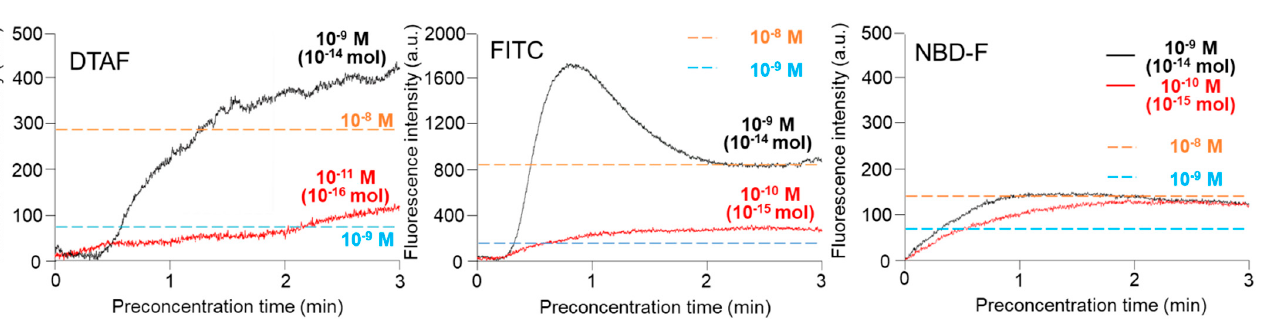
Figure 2. Time-course of fluorescence intensity changes of 5-(4,6-dichlorotriazinyl)aminofluorescein (DTAF), fluorescein isothiocyanate (FITC), and 4-fluoro-7-nitrobenzofurazan (NBD-F)-labeled monophosphorylated β -casein. The concentra- tions of DTAF, FITC, and NBD-F-labeled monophosphorylated β -casein are indicated on each trace. The orange and blue broken straight lines indicate the fluorescence intensities of DTAF, FITC, and NBD-F-labeled monophosphorylated β -casein at the channel crossing point in the absence of the Phos-tag acrylamide gel.